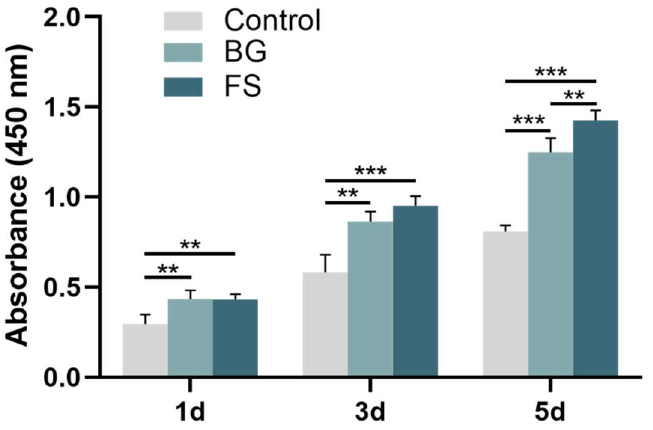
Figure 6. CCK8 assay of control, BG and FS group (** p < 0.01, *** p < 0.001).